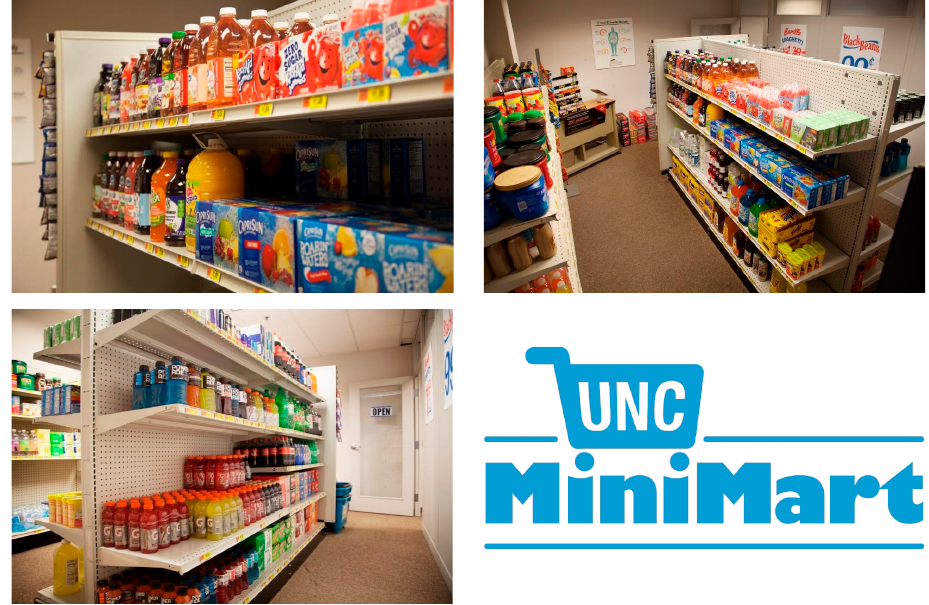
Figure 1. Photographs of and logo for UNC Mini Mart, a naturalistic store laboratory. After initially stocking the Mini Mart, we invited ten Latinx community members to visit. The community members navigated the store to provide input on what products they felt were missing and how we could better organize the store to seem more realistic. We then added several new products and made additional organizational changes to the store layout based on their